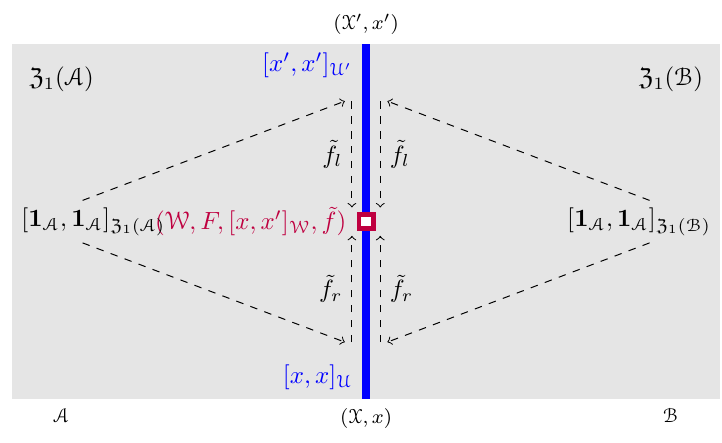
Figure 5 . Observables on the 2D worldsheet of rational